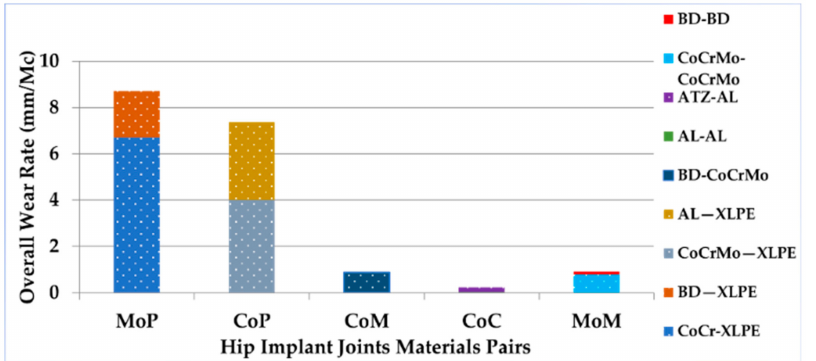
Figure 9. An illustration of wear rate/million cycles for different hip implant joint material